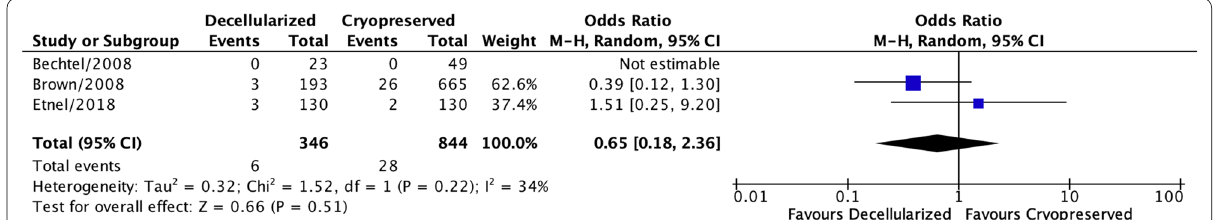
Fig. 2 Forest plot comparing early mortality in decellularized allografts versus cryopreserved allografts for patients undergoing right ventricular outflow tract reconstruction during the Ross procedure. MH Mantel–Haenszel, CI confidence interval